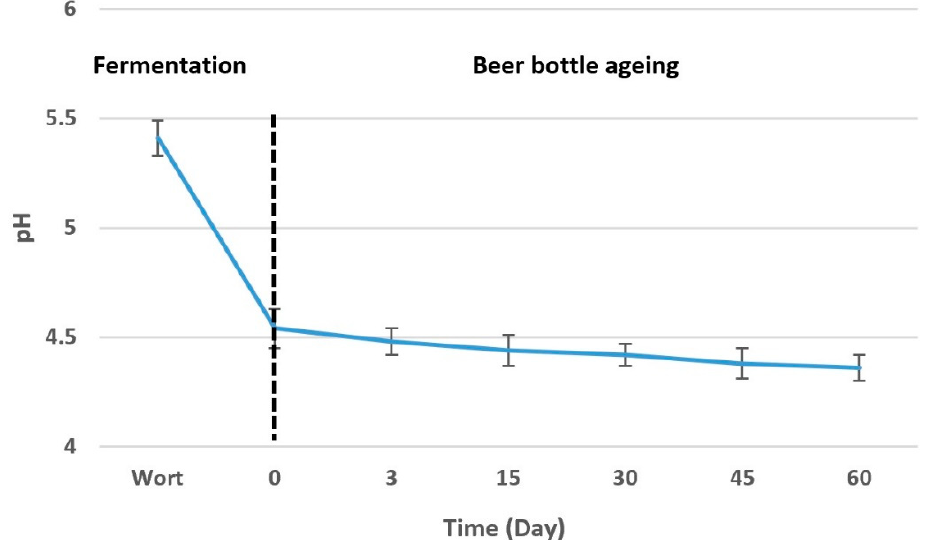
Figure 2. Changes in pH during the alcoholic fermentation and bottle ageing of probiotic beer.